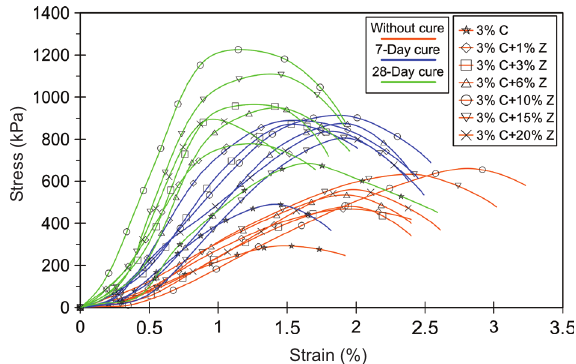
Figure 10 Influence of additives on the stress-strain curves of soil sample